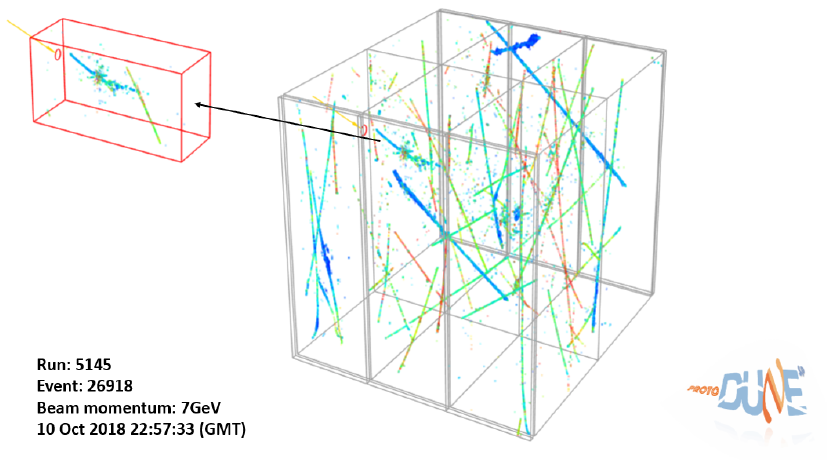
Figure 6. The ProtoDUNE-SP detector (gray box) showing the direction of the particle beam (yellow line on the very far left) and the outlines of the six APAs. Cosmic rays can be seen throughout the white box, while the red box highlights the beam region of interest with an interaction of the 7 GeV beam. The 3D points are obtained using the Space Point Solver reconstruction